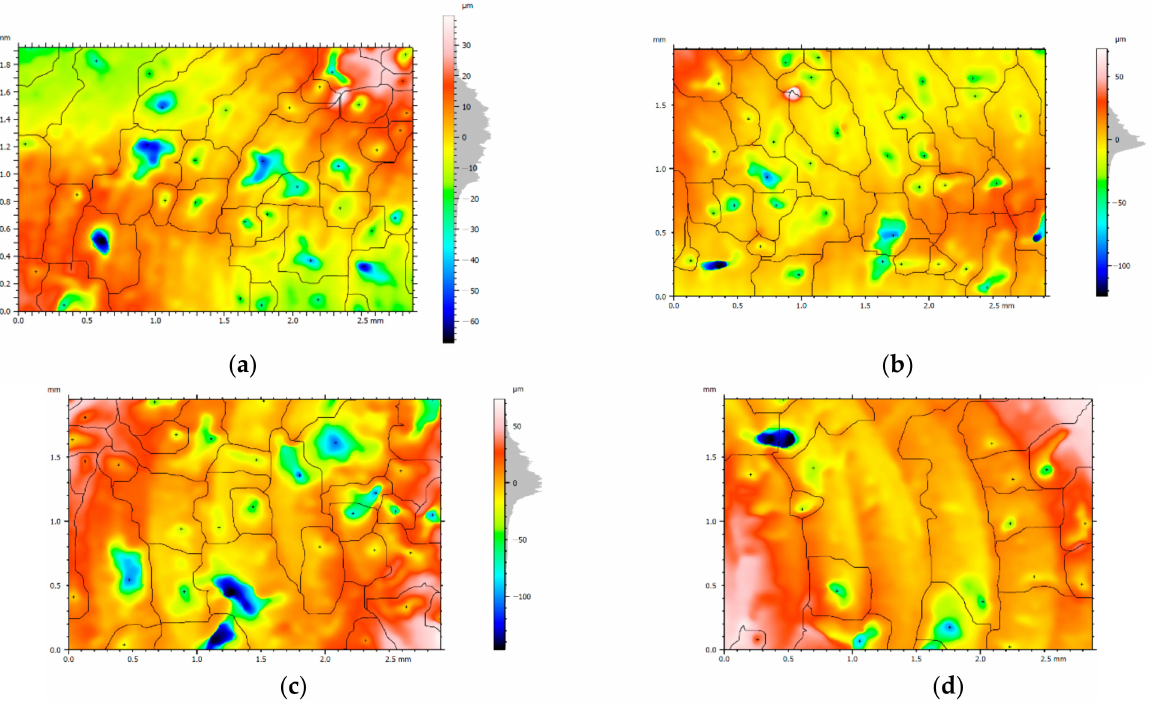
Figure 10. 3D Watershed segmentation—( a ) area for test 7 ( f = 0.013 mm/tooth, down milling), particle count 40, density 7.228 particles/mm 2 ( b ) area for test 8 (f = 0.013 mm/tooth, up milling), particle count 39, density 6.912 particles/mm 2 ( c ) area for test 1 ( f = 0.05 mm/tooth, down milling), particle count 34, density 6.014 particles/mm 2 ( d ) area for test 2 ( f = 0.05 mm/tooth, counter-rotating milling), particle count 20, density 3.569 particles/mm 2